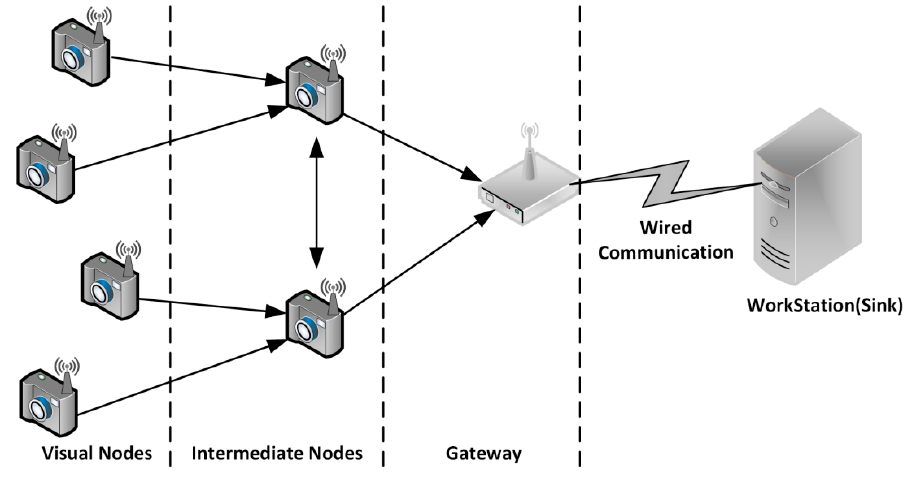
Figure 1. Architecture of a VSN.